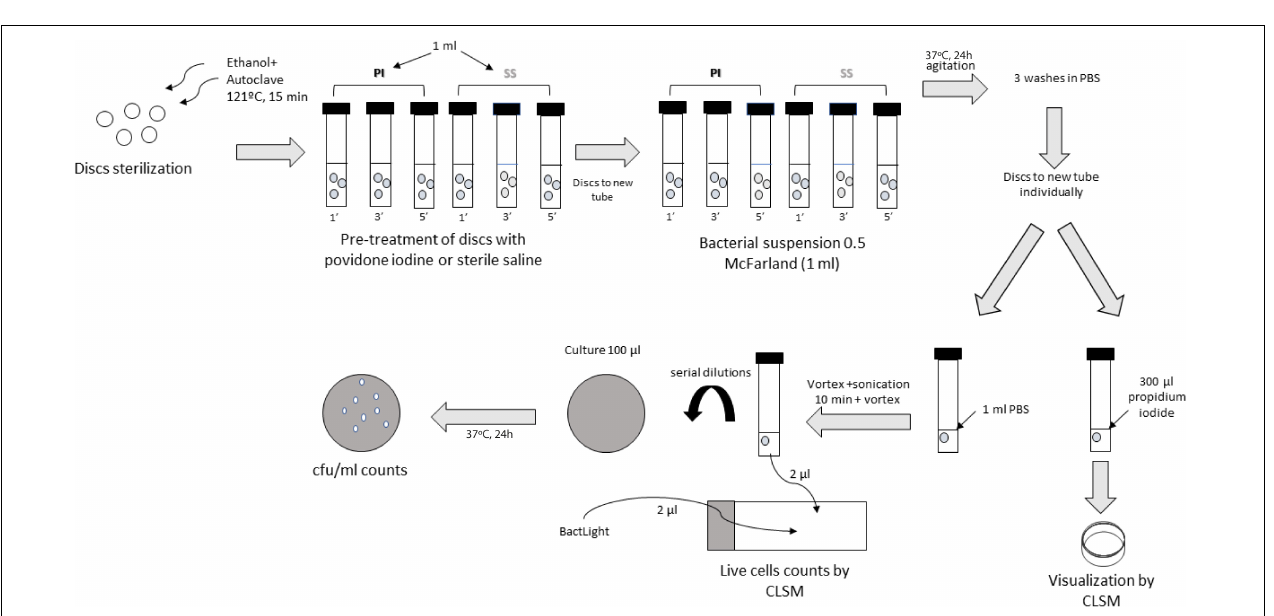
FIGURE 2 | Laboratory